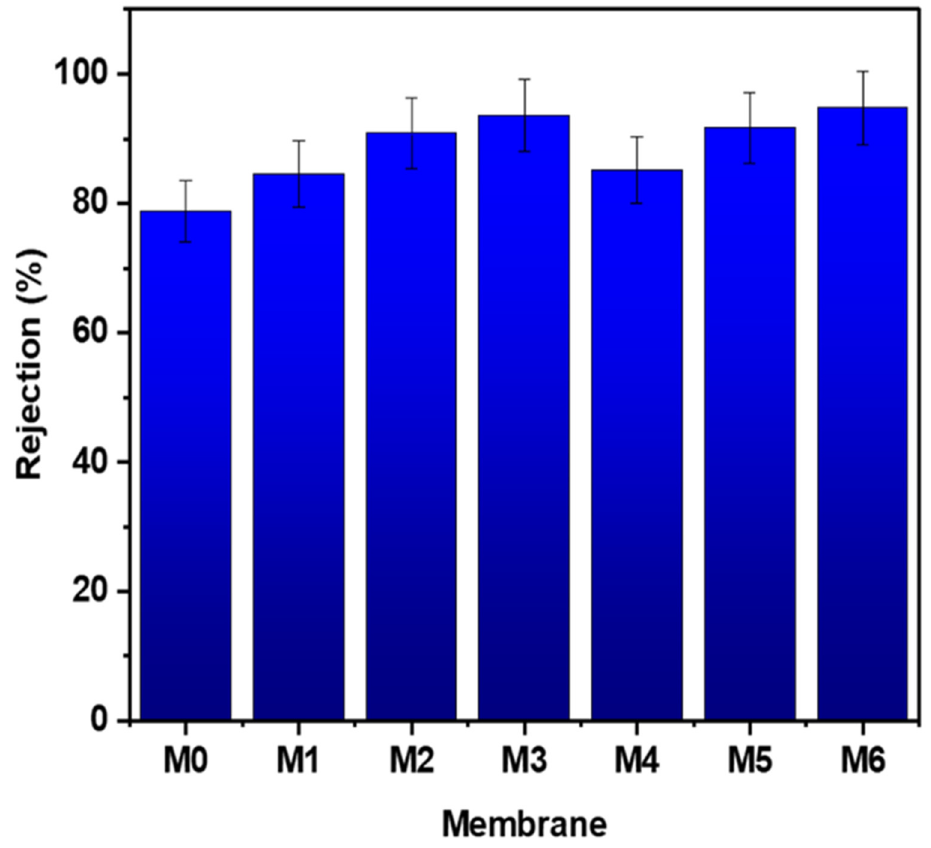
Figure 10. HA rejection with different PES hybrid membranes at pH =